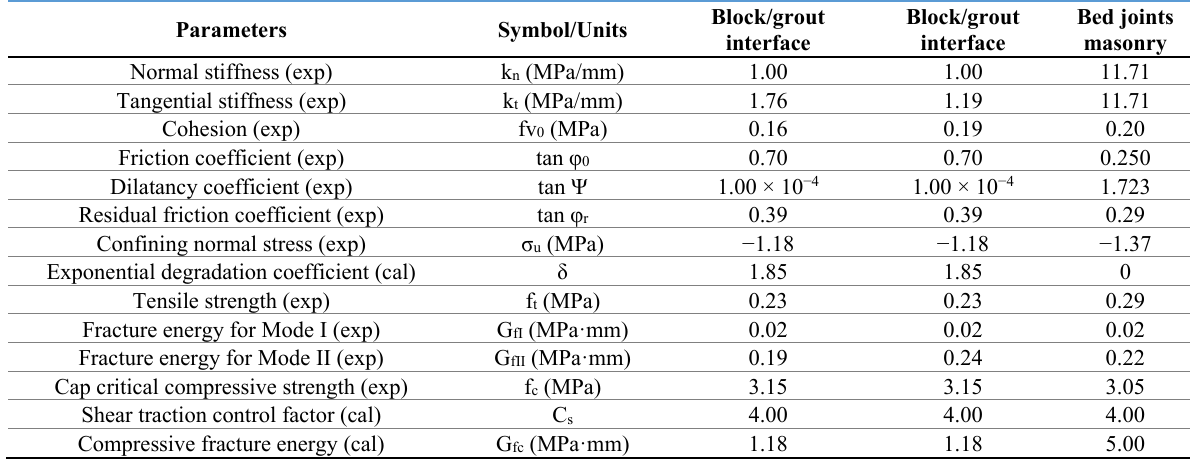
Table 8. Mechanical properties of the Composite Interface Model (block/grout interface and the bed joints masonry). Parameters